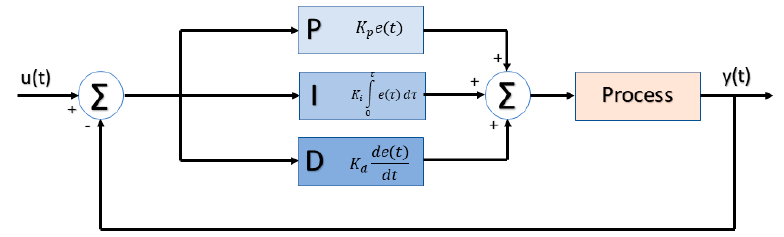
Figure 4. Atmospheric enclosure block diagram with a proportional integral derivative (PID) controller.